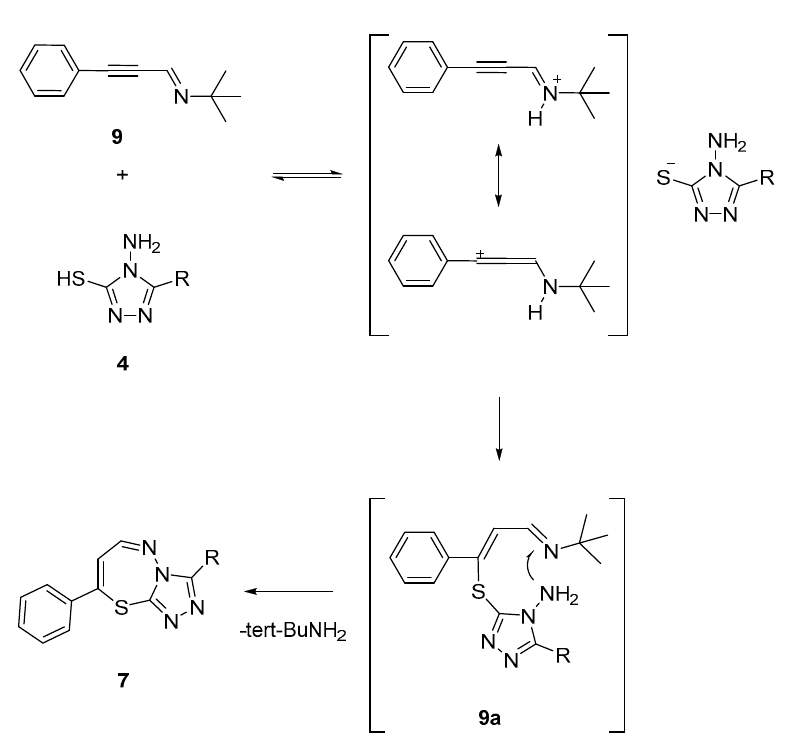
Figure 7. Proposed reaction mechanism for the formation of triazolothiadiazepines 7